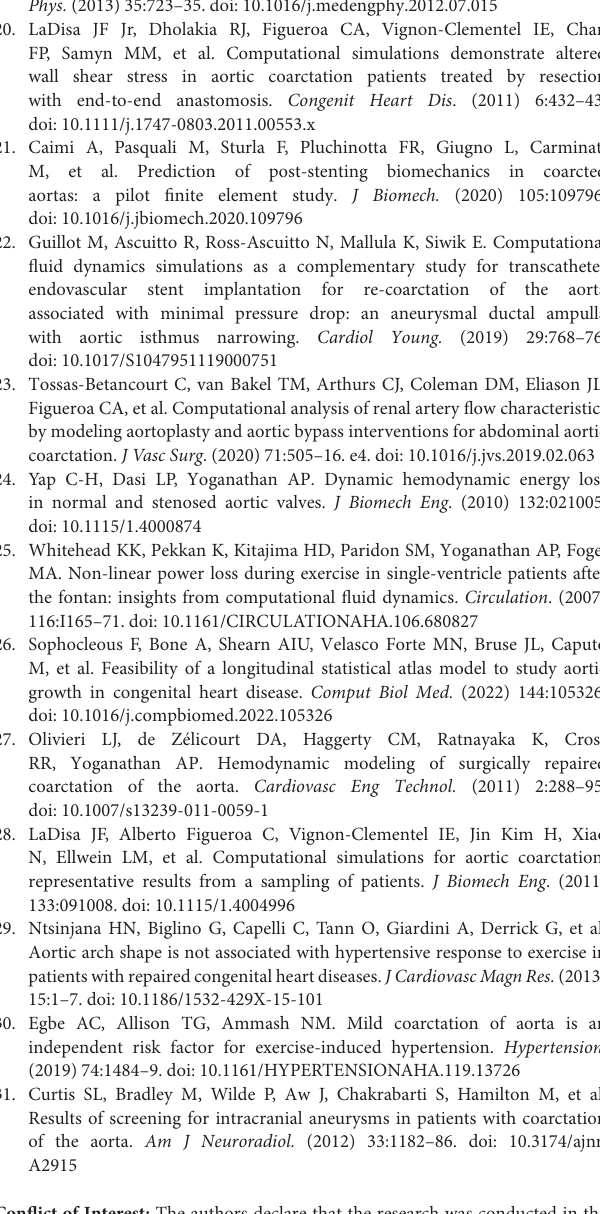
Figueroa CA, et al. Computational analysis of renal artery flow characteristics by modeling aortoplasty and aortic bypass interventions for abdominal